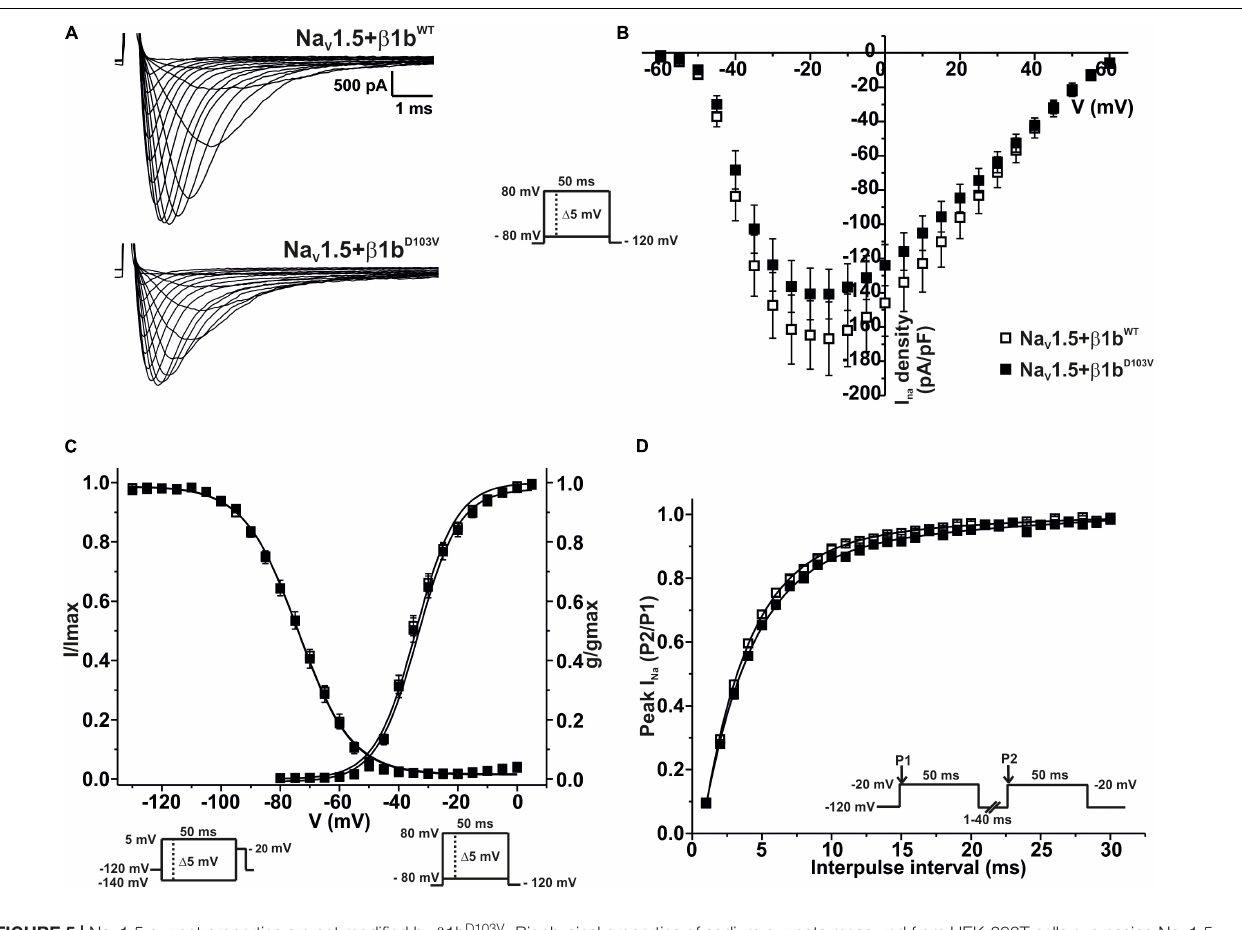
FIGURE 5 | Na V 1.5 current properties are not modified by β 1b D103V . Biophysical properties of sodium currents measured from HEK-293T cells expressing Na V 1.5 co-expressed with either β 1b WT or β 1b D103V . Whole cell currents were elicited by depolarizing potentials as shown in the insets. Open squares are used to depict data for Na V 1.5+ β 1 WT and filled squares for Na V 1.5+ β 1 D103V . Solid lines in panels (C) and (D) represent the fitted curves. Values are expressed as mean ± SEM. (A) Representative whole-cell Na + current traces from HEK-293T cells expressing Na V 1.5+ β 1b WT (top), and Na V 1.5+ β 1b D103V (bottom). (B) Mean current-voltage relationship. I Na amplitude was normalized to the cell capacitance to obtain I Na density values. (C) I Na steady-state voltage dependence of activation and inactivation plots. (D) Recovery from inactivation